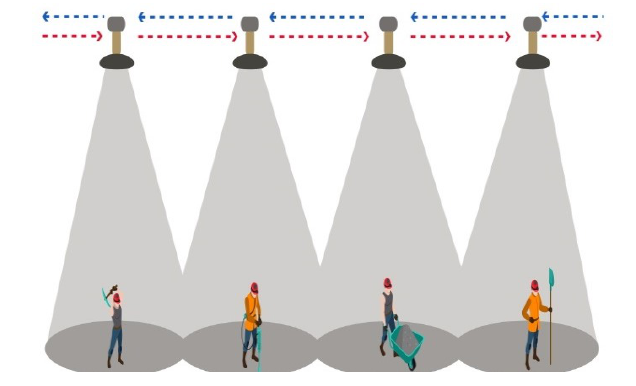
Figure 1. Fundamental visible light communication (VLC) model for underground coal